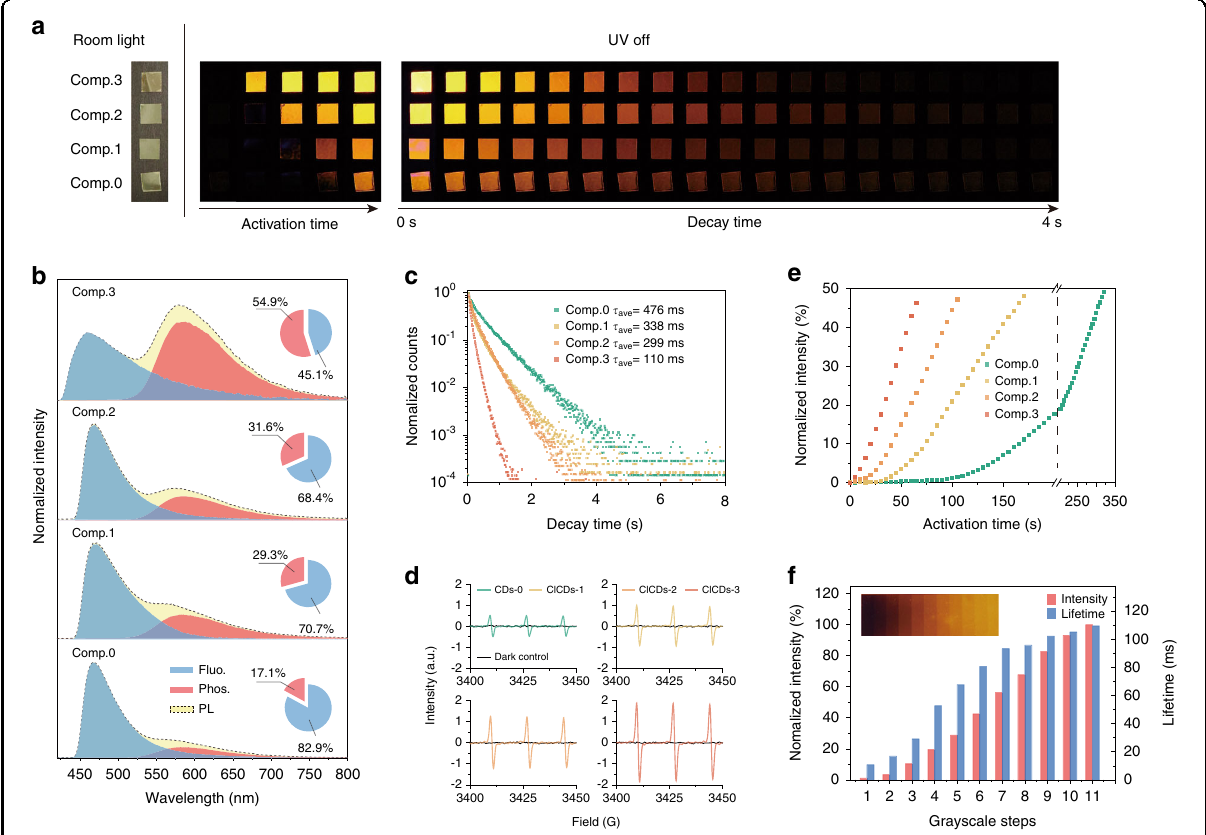
Fig. 3 DURTP characteristics of CDs/PVP composites with different halogen contents. a Photographs depicting the photoactivation and decay features of four CDs/PVP composites. b The phosphorescent component in the total photoluminescence of four CDs/PVP composites. c The lifetime decay pro fi les of the four CDs/PVP composites (activated). d ESR signals of TEMP-captured 1 O 2 at 0 min (dark control) and 2 min after UV irradiation in the presence of the four different CDs (20 μ g/ml). e Photoactivation pro fi les of the four CDs/PVP composites. f The changes in the lifetimes and intensities of composite 3 corresponding to the effective UV dose at different grayscale